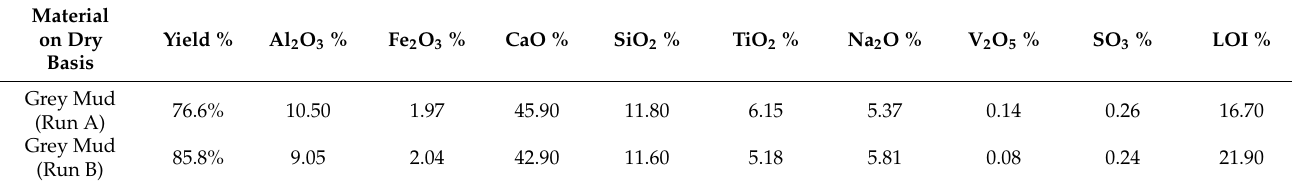
Table 8. Percent yield and corresponding chemical analysis of the produced filtercakes (grey muds) from the pilot scale tests.